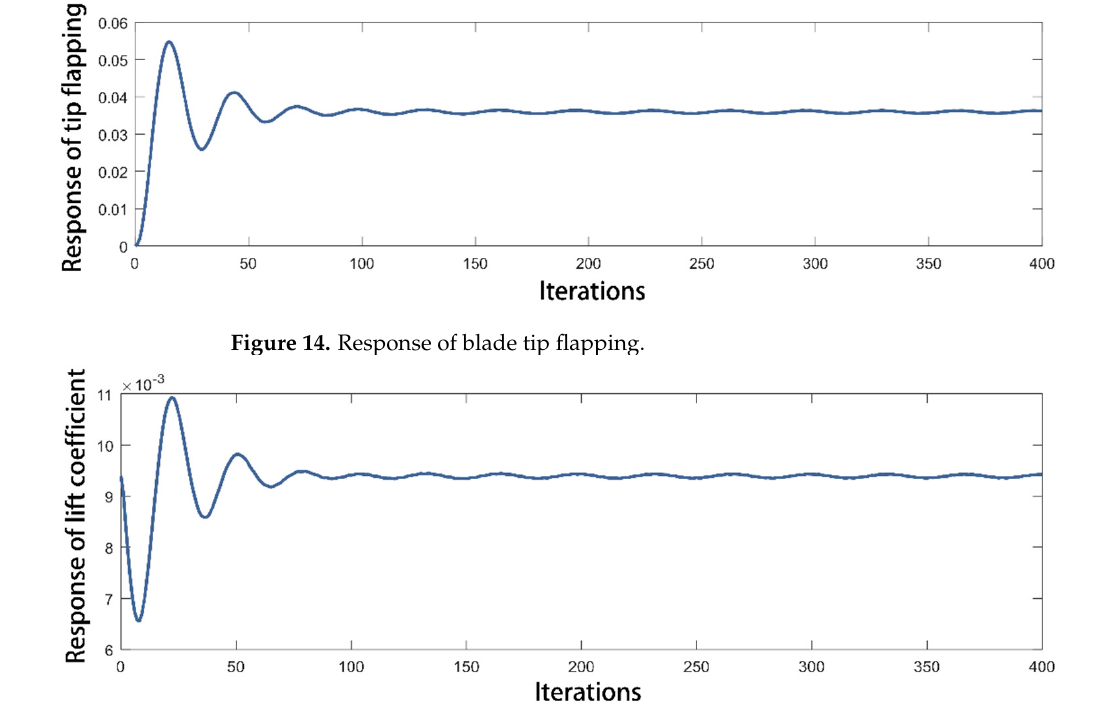
Figure 15. Response of rotor lift coefficient.